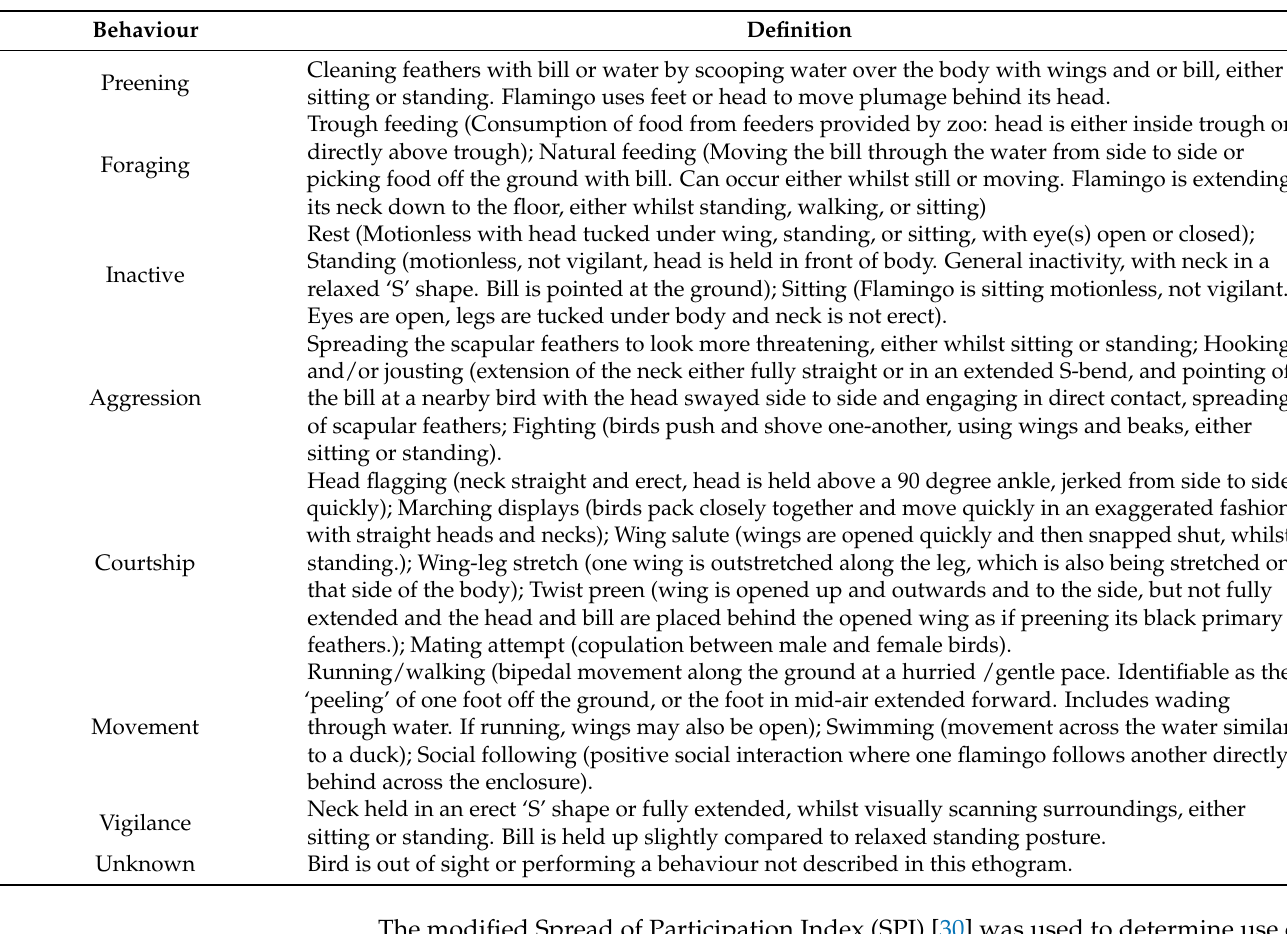
Table 2. Ethogram of flamingo state